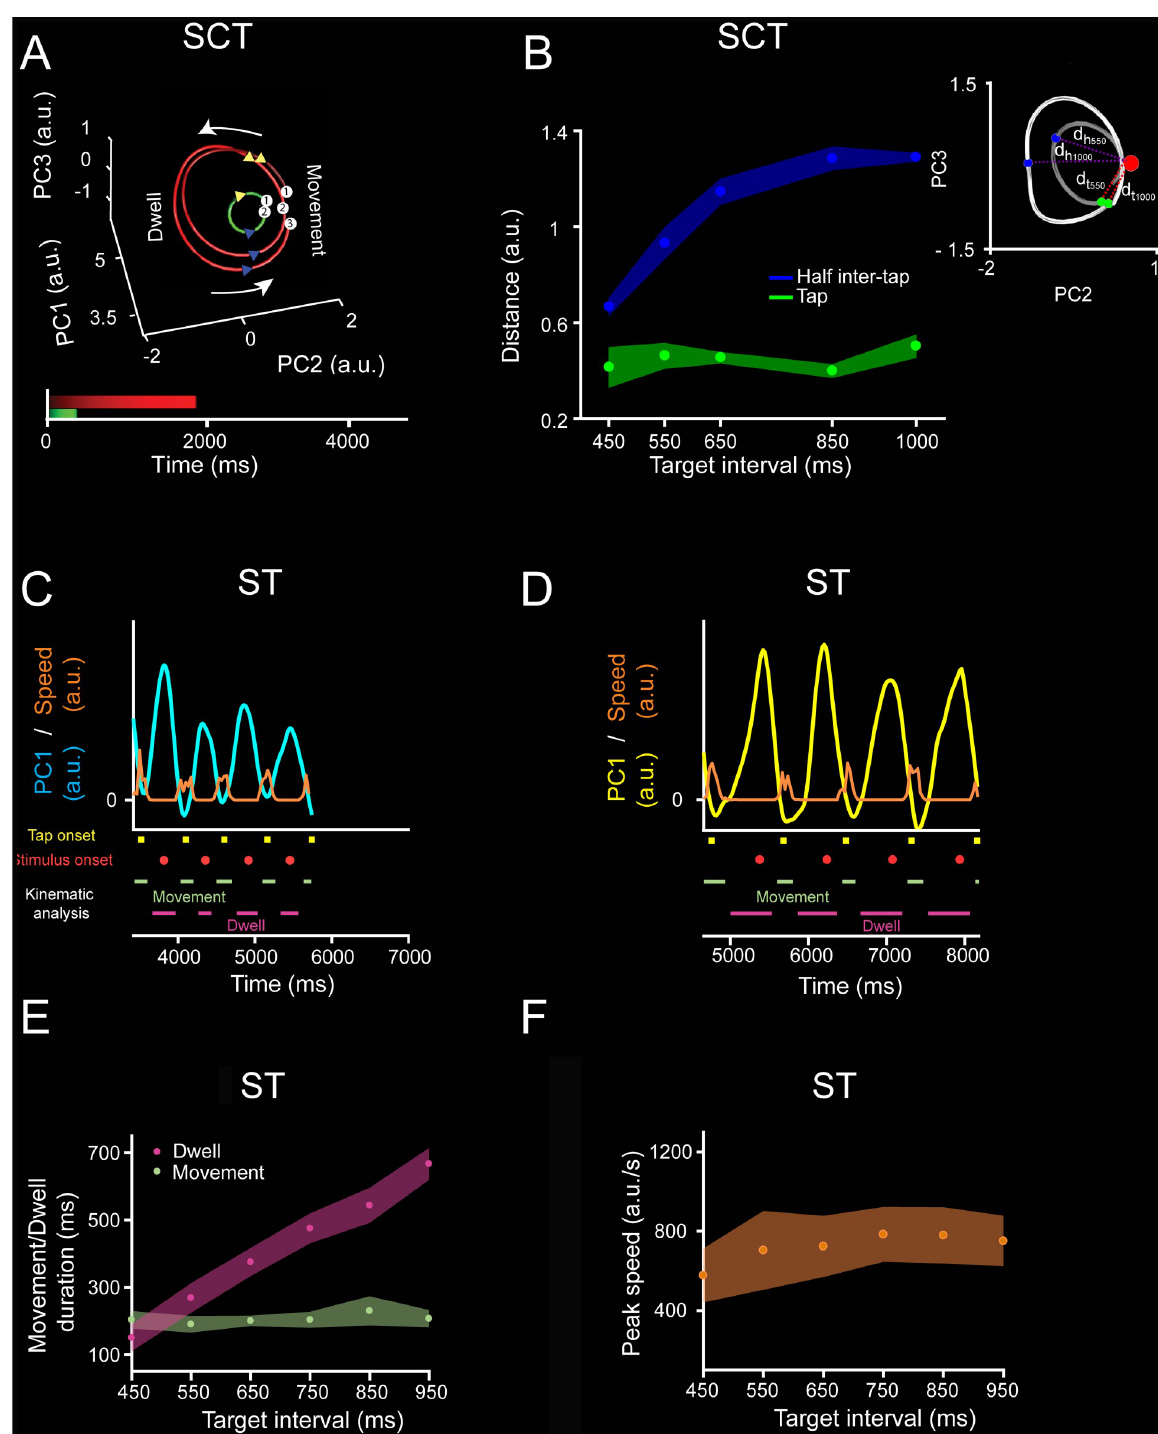
Fig 5. Neural trajectories do not follow the tapping kinematics. A . Diagram of the rotational trajectory of the SCT neural activity during three inter-tap intervals: one 450-ms interval (green) and two 1,000-ms intervals (red). Each tap is numbered and projected in the trajectory as a white circle. A blue triangle marks the beginning, whereas a yellow triangle marks the end of the movement time. The monkeys produced phasic stereotypic movements whilst timing the dwell between taps during SCT [37]. B. Euclidean distance (d t , see inset) between an anchor point (red) and the position of each tap (green, mean ± SD, slope = 0.00007, R 2 = 0.0633, p = 0.225), or half of the inter-tap interval position on the neural trajectories (blue, mean ± SD, slope = − 0.001, R 2 = 0.801, p < 0.0001) across target intervals for SC. A two-way ANOVA detected significant main